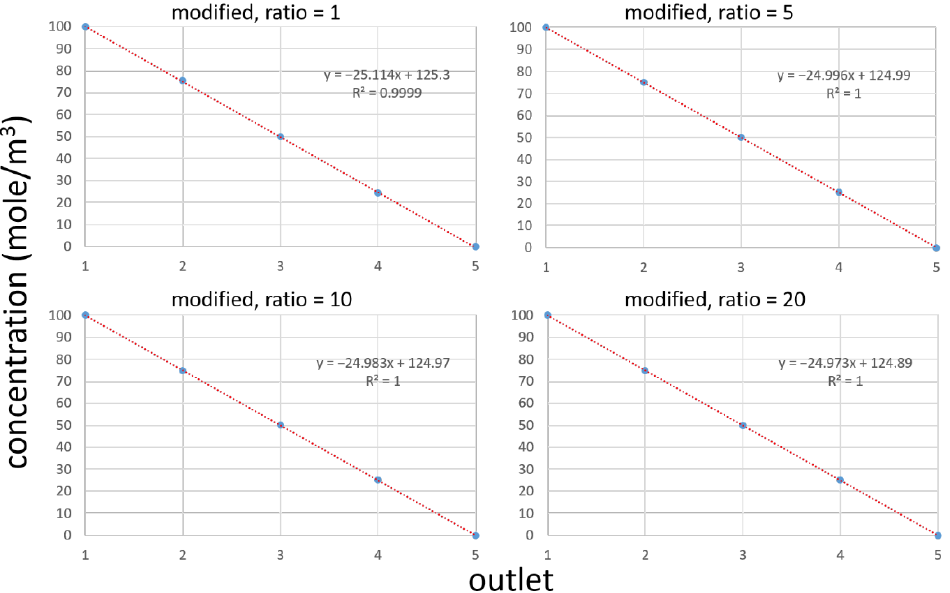
Figure 11. Simulation of chemical concentrations for modified devices with different ratios of R V / R H .